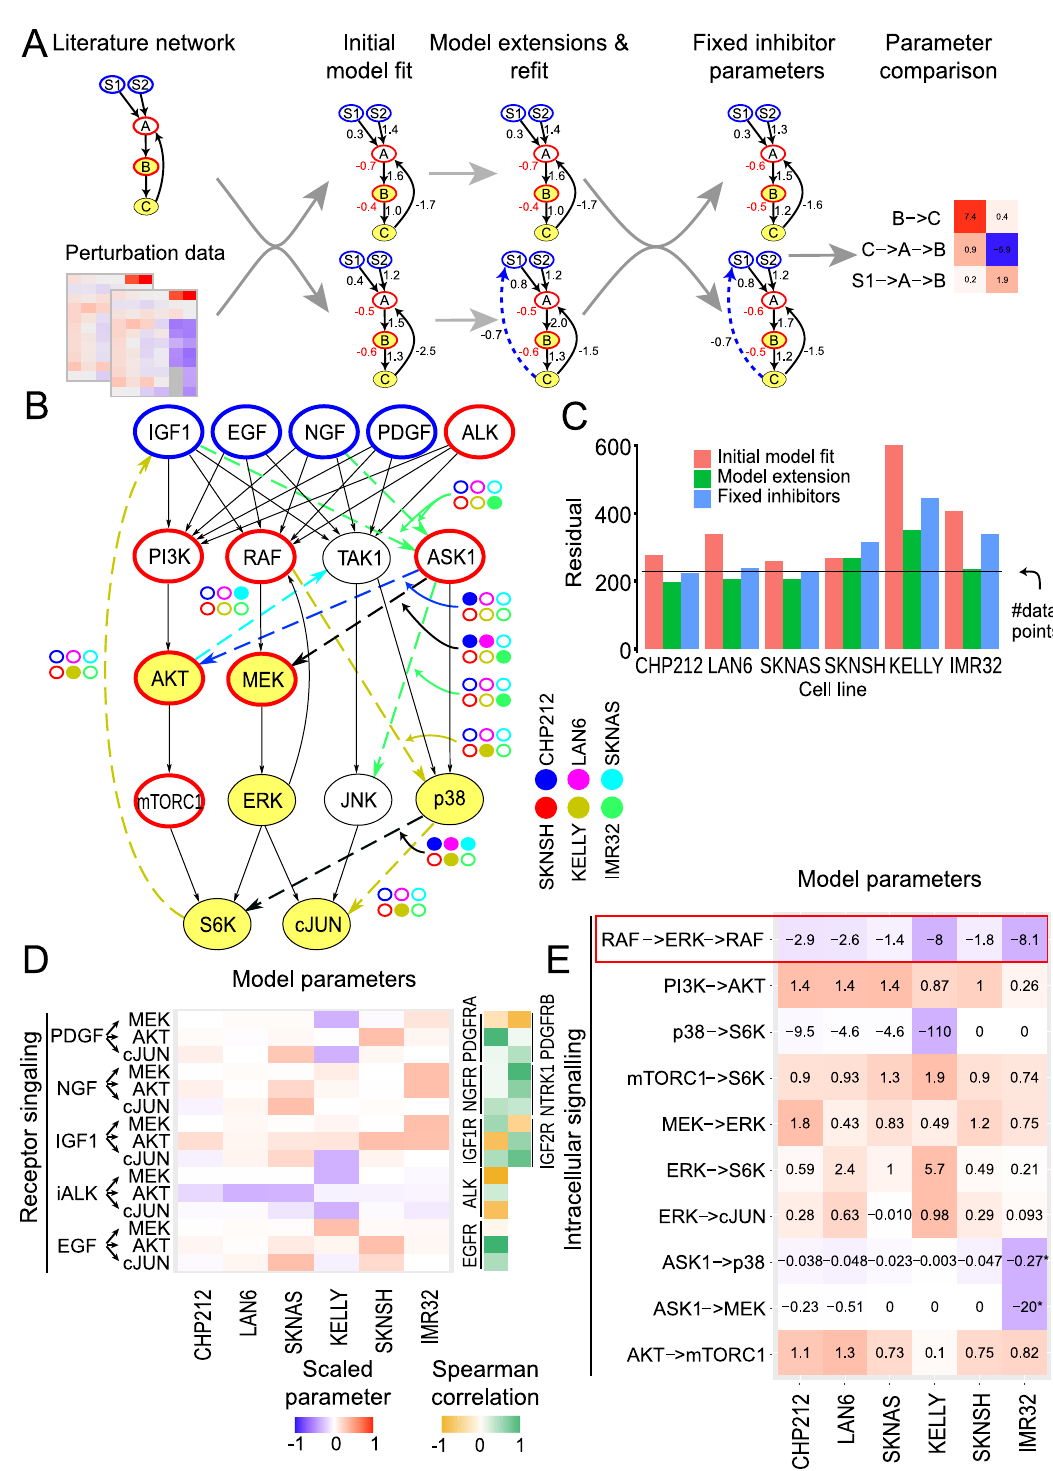
Fig 3. Receptor expression and topology variations explain the heterogeneity in perturbation response. A: Starting from a literature-derived network, a model was fitted for each cell line (Initial model fit) and extended following suggestions from the model (Model extensions and refit). Those models with different network structures were then harmonised by fixing the inhibition parameters to a consensus value (Fixed inhibitor parameters) to make the parameters directly comparable (Parameter comparison). B: Model residuals before and after model extension and harmonisation. The black line represents the number of data points, which